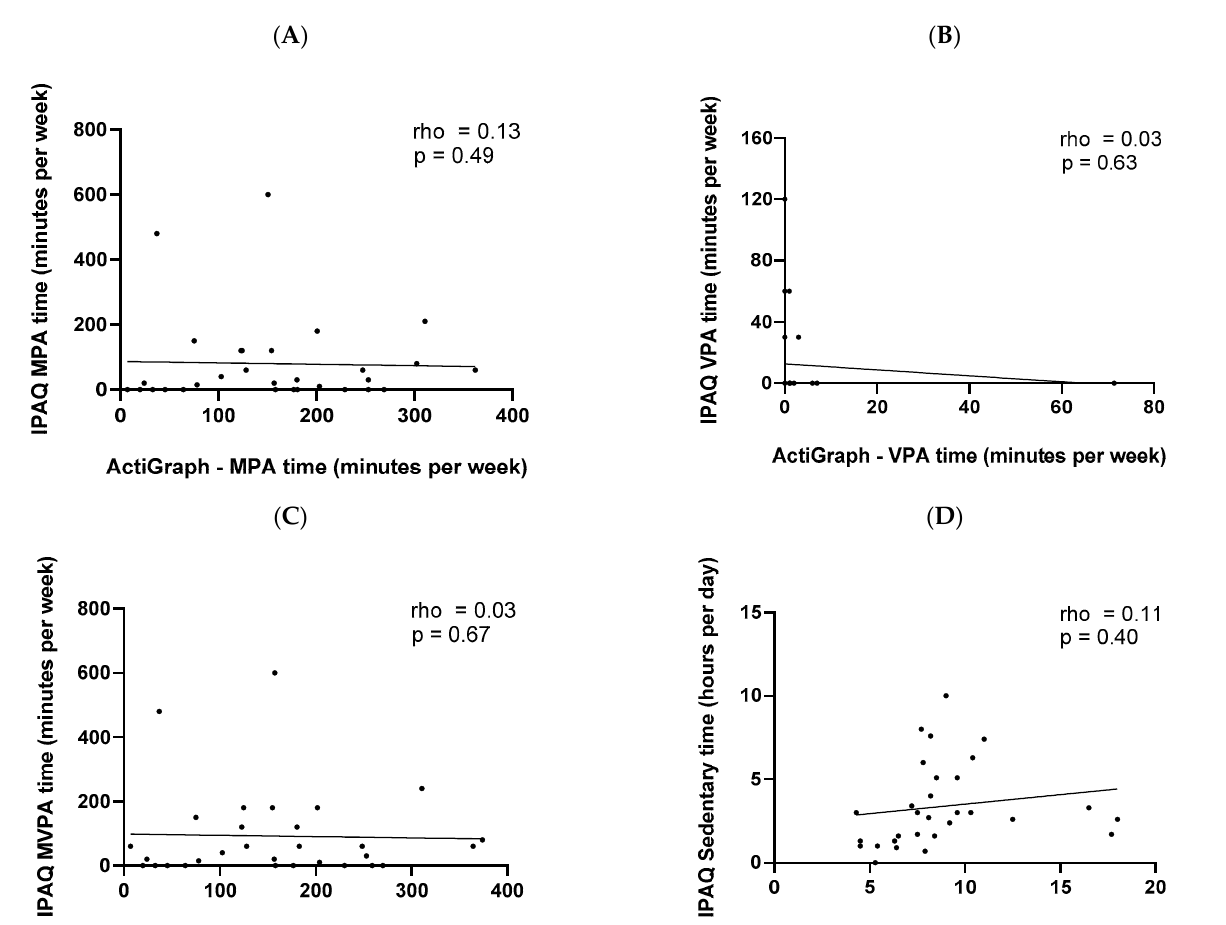
Figure 2. Associations between the IPAQ and ActiGraph ® (Spearman correlation) measures regarding major depressive disorder or bipolar disorder: for MPA—Panel ( A ); VPA—Panel ( B ); MVPA—Panel ( C ); sedentary behavior—Panel ( D ); rho = Spearman’s Correlation Coefficient; MPA = moderate physical activity; VPA = vigorous physical activity; MVPA = moderate and vigorous physical